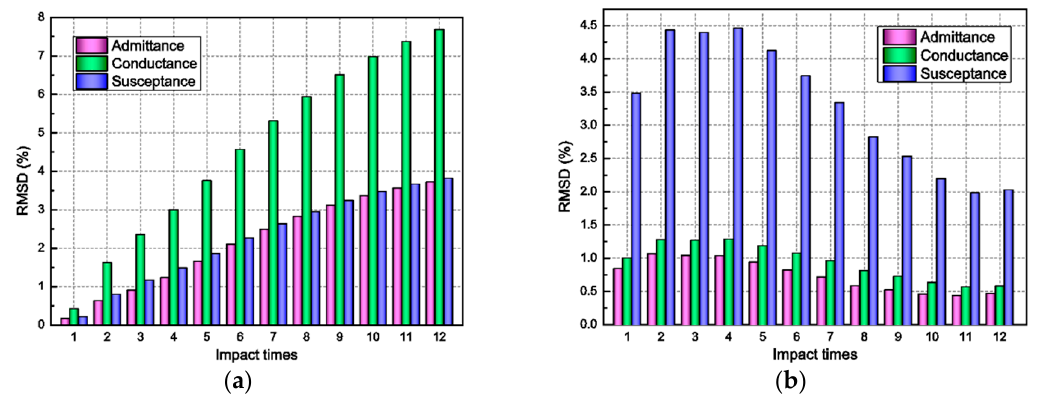
Figure 8. The RMSD damage metrics of the admittance signatures: ( a ) RMSD changes of PZT-F with impact times; and ( b ) RMSD changes of PZT-R with impact times. impact times; and ( b ) RMSD changes of PZT-R with impact times.